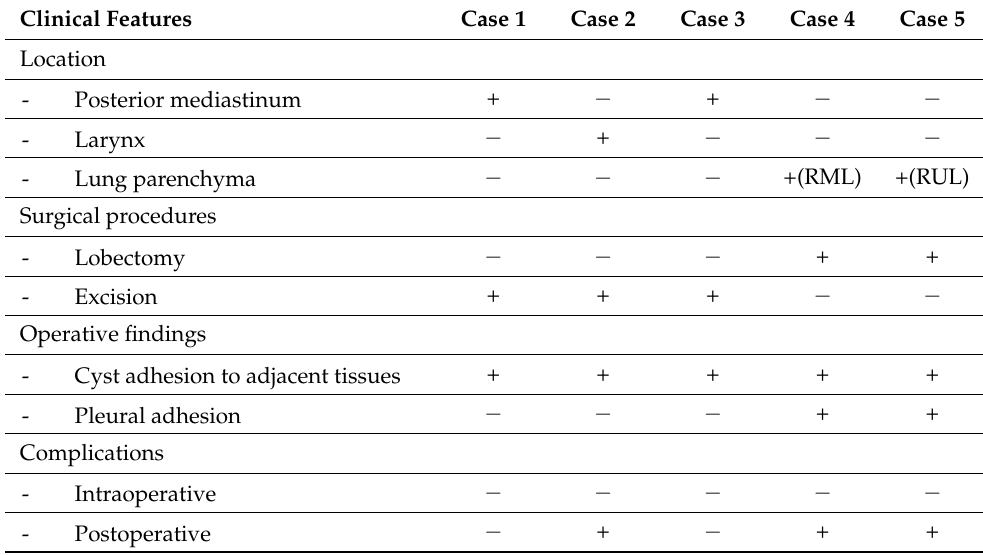
Table 2. Cyst location, surgical procedures, operative findings, and